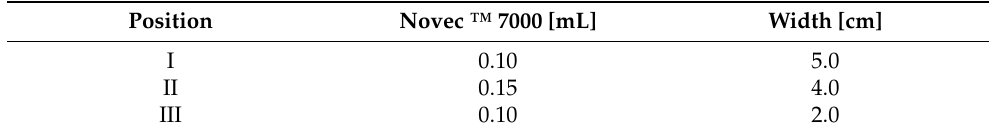
Figure 9. Differences in the pressure distribution between handshakes and pouch actuators at ( a ) position I, ( b ) position II and ( c ) position III. Table 1. Pouches selected for each position.